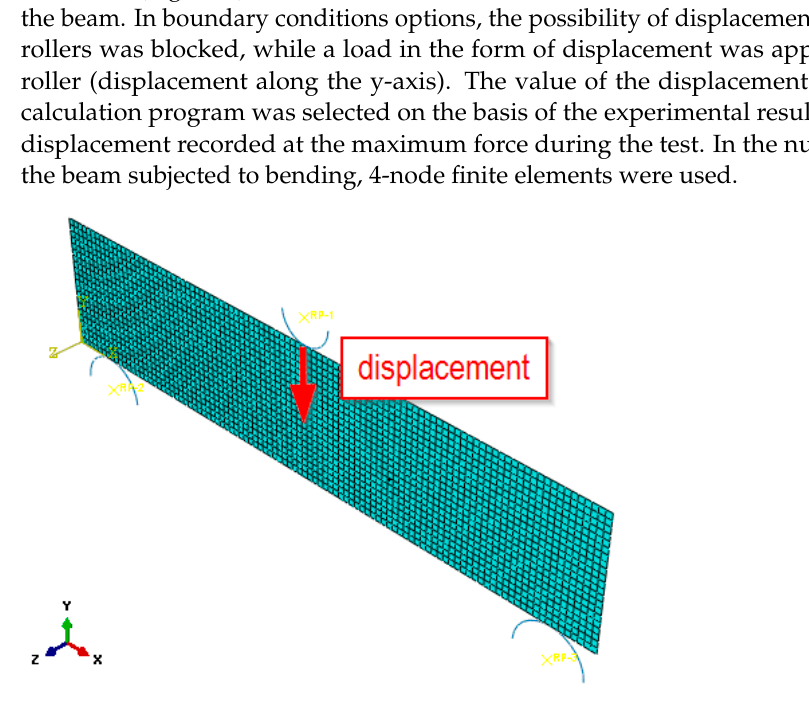
Figure 6. Numerical model of a three-point fibre concrete beam subjected to bending.